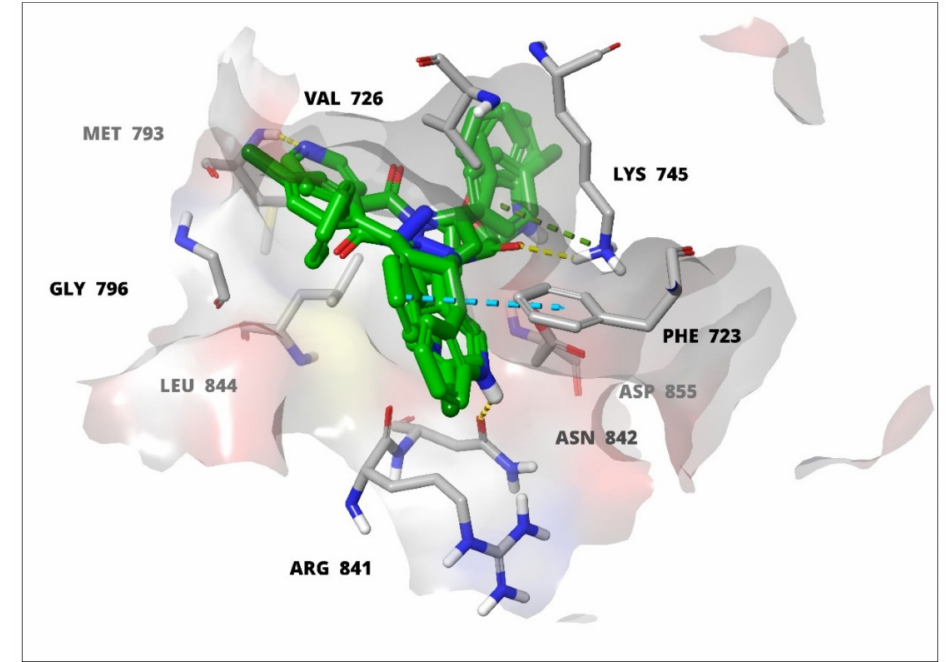
Figure 6. 3D in silico view of HD02, HD05, and HD12 at active site of the